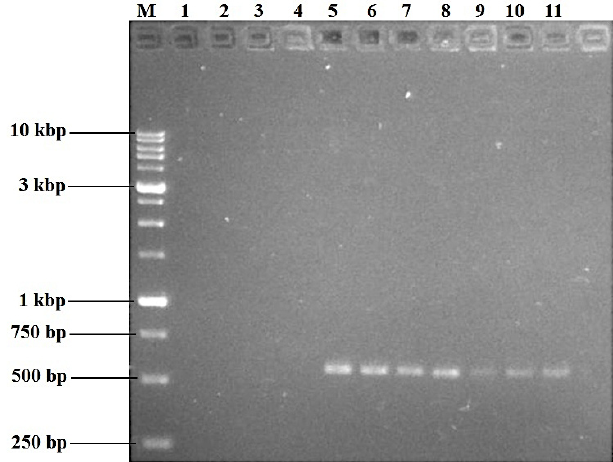
(lanes 8 to 11) using the designed SCAR primer pair (CKL_f / CKL_r). Lane M represents the 1.0 kb DNA ladder (Promega, USA).